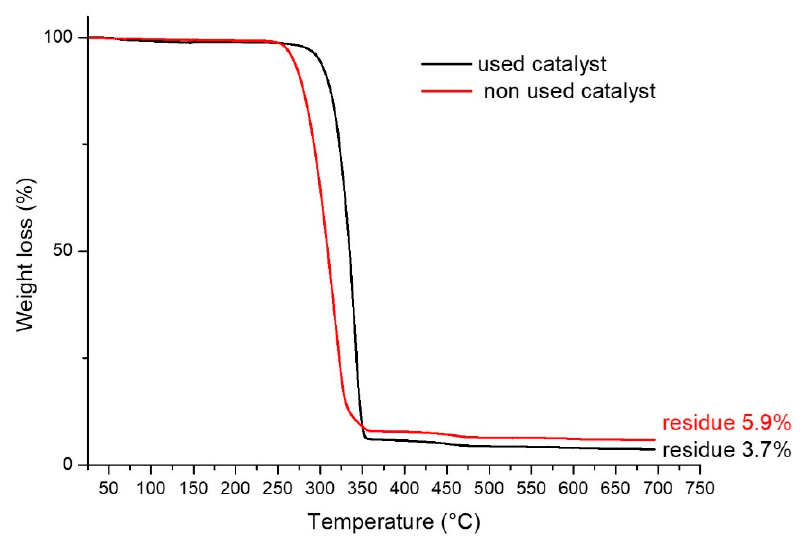
Figure 7. Thermogravimetric analysis of the catalyst before its use and after 3 reaction and regeneration cycles .